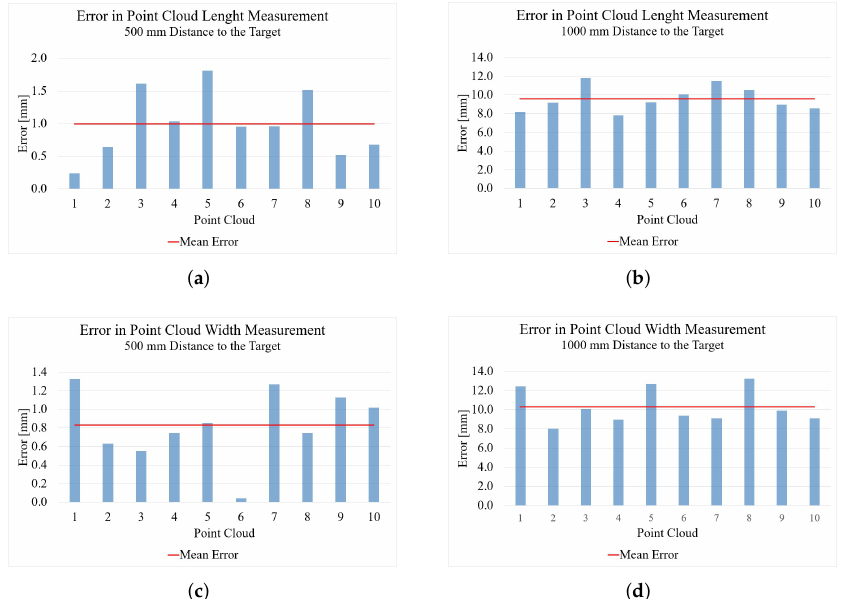
Figure 8. Results of the foot measurement with the Microsoft Kinect Azure ToF camera: ( a ) length results from 500 mm; ( b ) length results from 1000 mm; ( c ) width results from 500 mm; ( d ) width results from 1000 mm.